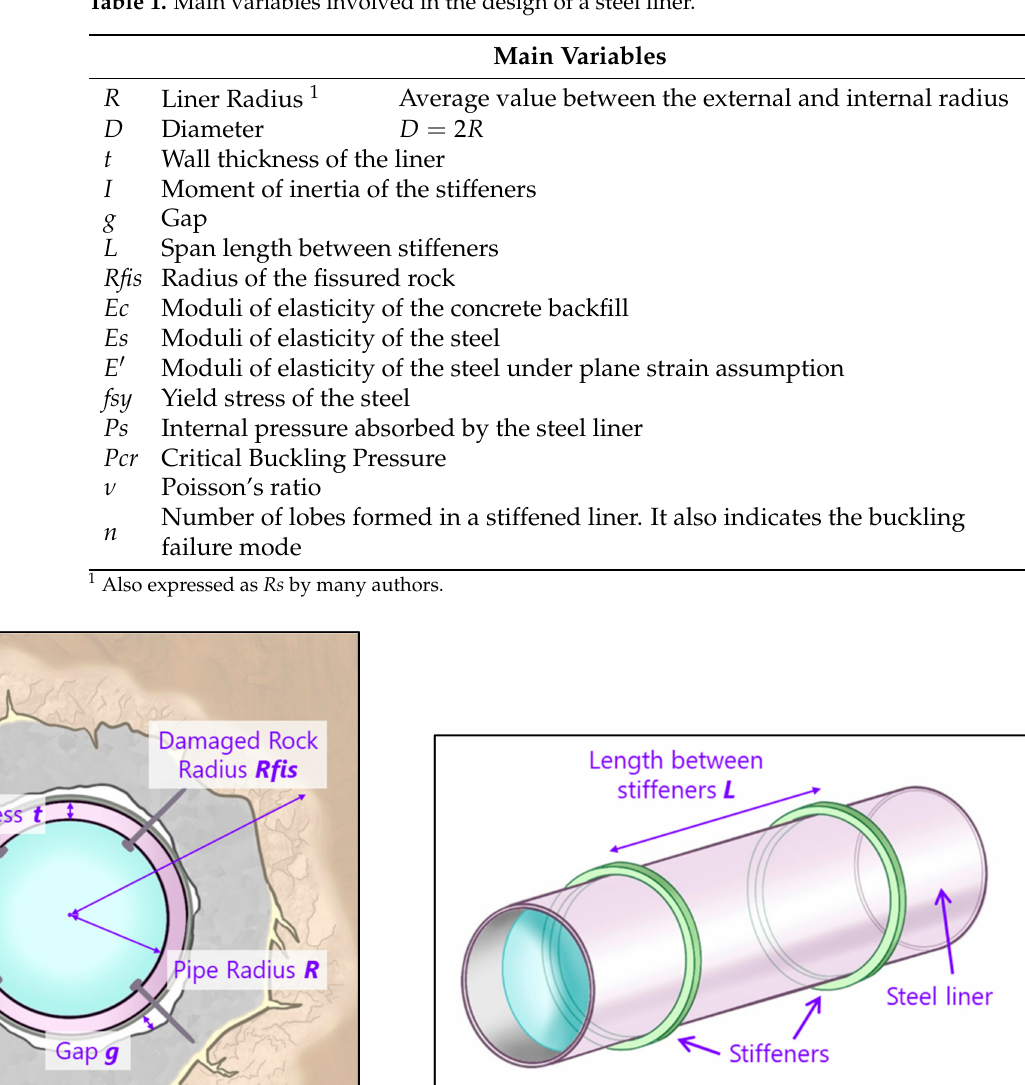
Table 1. Main variables involved in the design of a steel liner.